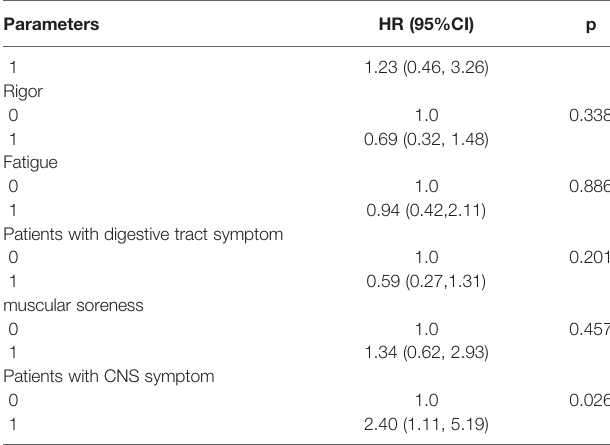
TABLE 7 | Univariate cox regression analysis of risk factors for disease prognosis. Parameters